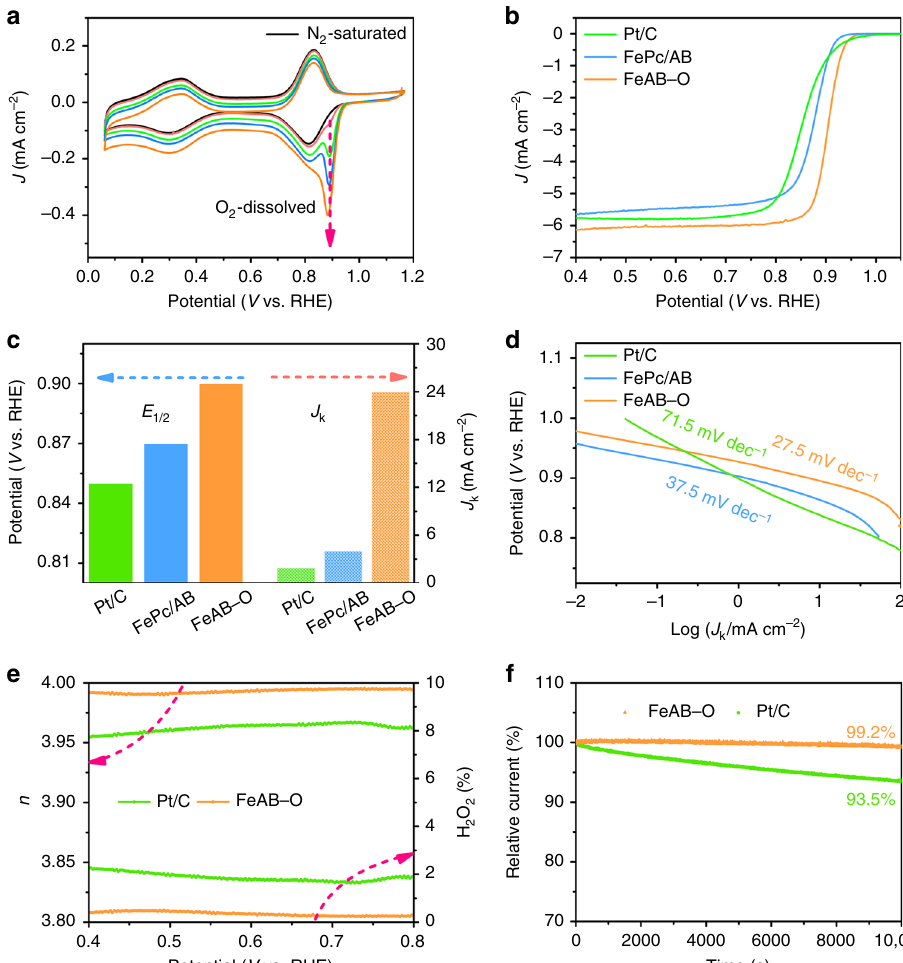
Fig. 4 Electrochemical ORR performances. a Cyclic voltammetry pro fi les of FeAB – O in N 2 -saturated and O 2 -dissolved 0.1 M KOH solution. b ORR polarization curves of FeAB – O, FePc/AB, and Pt/C in O 2 -saturated 0.1 M KOH. c Values of half-wave potentials and J k at 0.88 V of FeAB – O, FePc/AB, and Pt/C. d Corresponding Tafel plots of FeAB – O, FePc/AB, and Pt/C. e Electron transfer numbers and proportion of produced H 2 O 2 in FeAB – O and Pt/C. f I – t chronoamperometry responses (in O 2 -saturated 0.1 M KOH with a rotation of 1600 rpm) of FeAB – O and